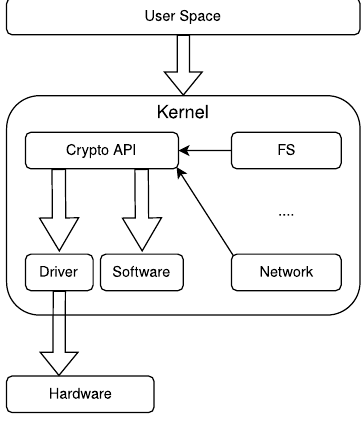
Figure 2. Linux Crypto API